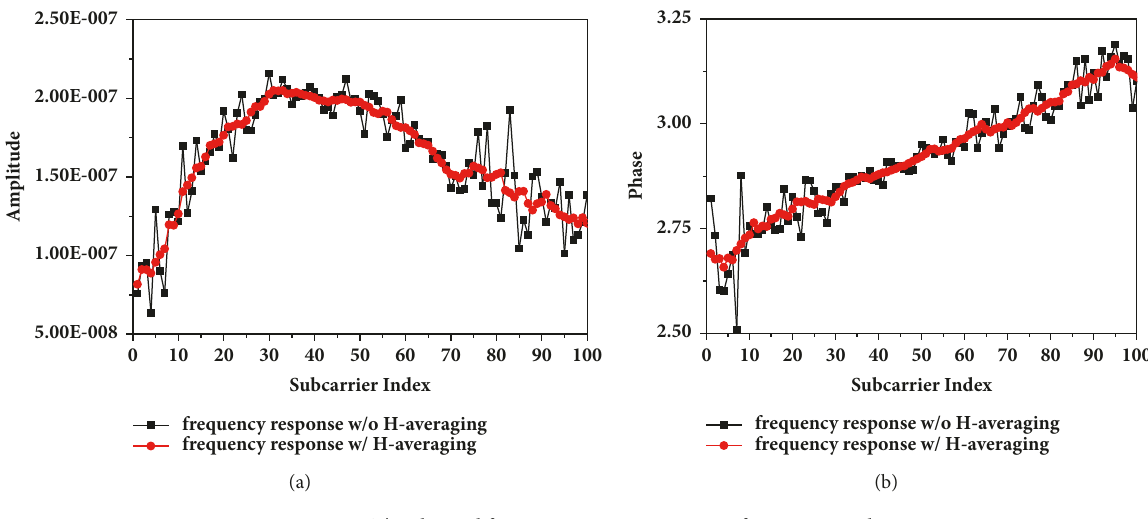
Figure 5: The channel frequency response curves of OFDM signal.